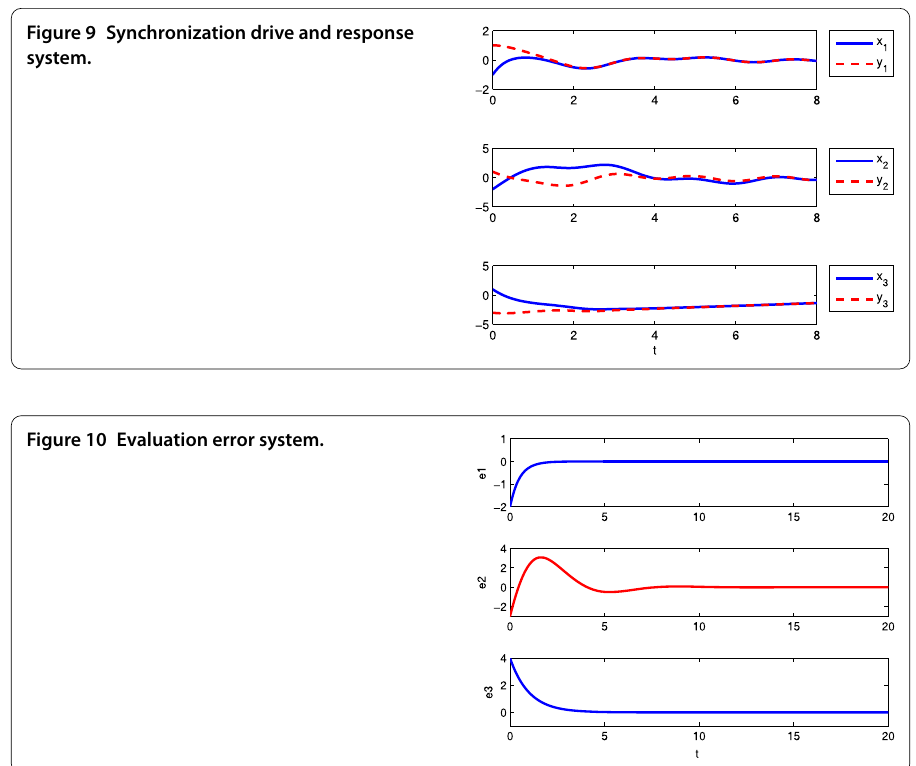
Figure 9 Synchronization drive and response system.